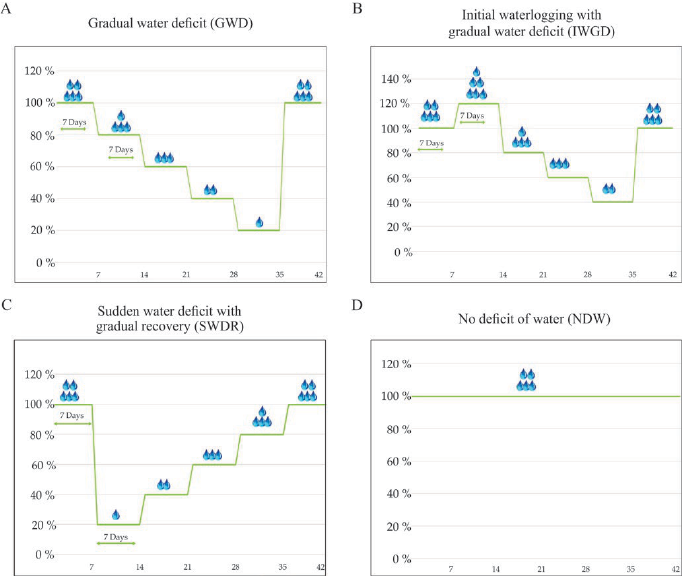
at di ff erent types of water stress. ( A ) gradual water deficit (GWD); ( B ) Initial waterlogging with gradual water deficit (IWGD); ( C ) Sudden water deficit with gradual recovery (SWDR); ( D ) No deficit of water (NDW). The Y-axis represents the percentage of the volume of water that corresponds to the field capacity and the X-axis represents the days during which the irrigation volume was